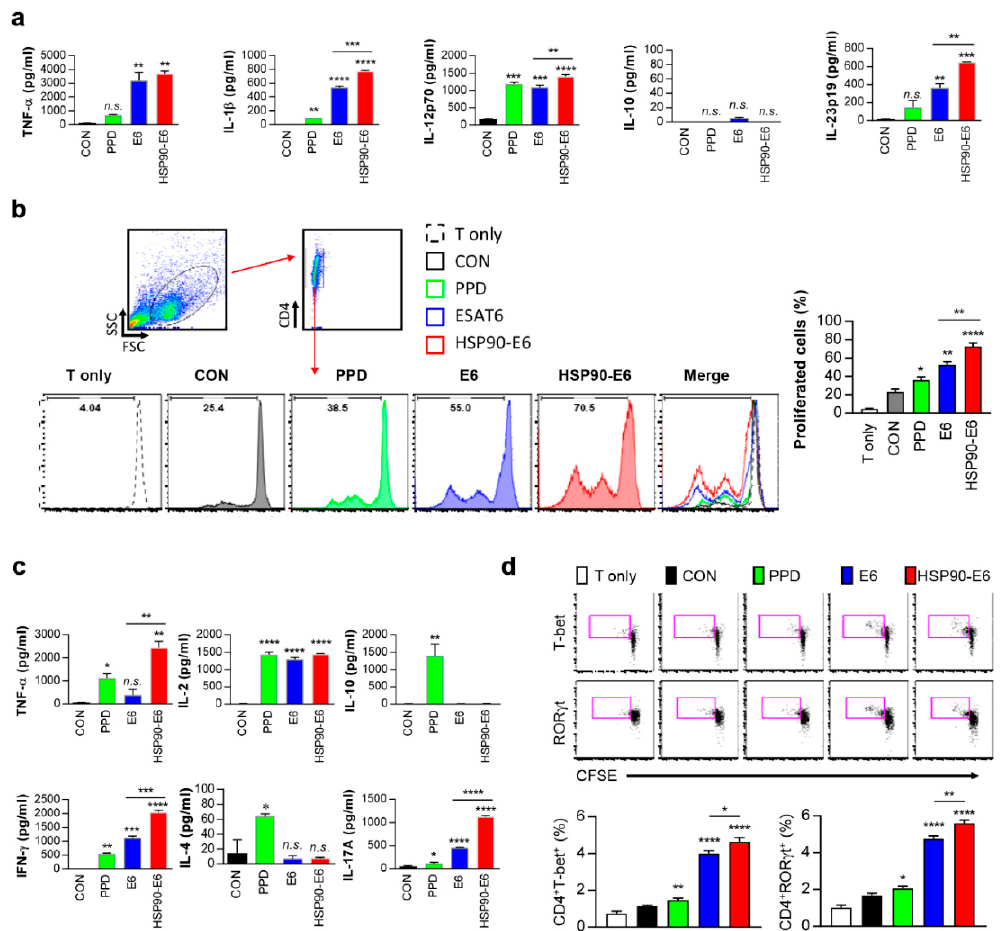
Figure 6. T-cell proliferation and di ff erentiation induced by HSP90-E6-treated dendritic cells (DCs). ( a ) DCs were activated with PPD (2 µ g / mL), ESAT-6 (2 µ g / mL), or HSP90-E6 (2 µ g / mL) for 24 h. TNF- α , IL-1 β , IL-12p70, IL-10, and IL-23p19 levels in the culture medium were measured by ELISA. Data are the mean ± SD (n = 3). ( b ) CD4 + T-cells were isolated from the spleens of individually vaccinated mice, stained with carboxyfluorescein succinimidyl ester (CFSE), and co-cultured with DCs treated with PPD (2 µ g / mL), E6 (2 µ g / mL), or HSP90-E6 (2 µ g / mL) for 3 days. T-cells alone and T-cells